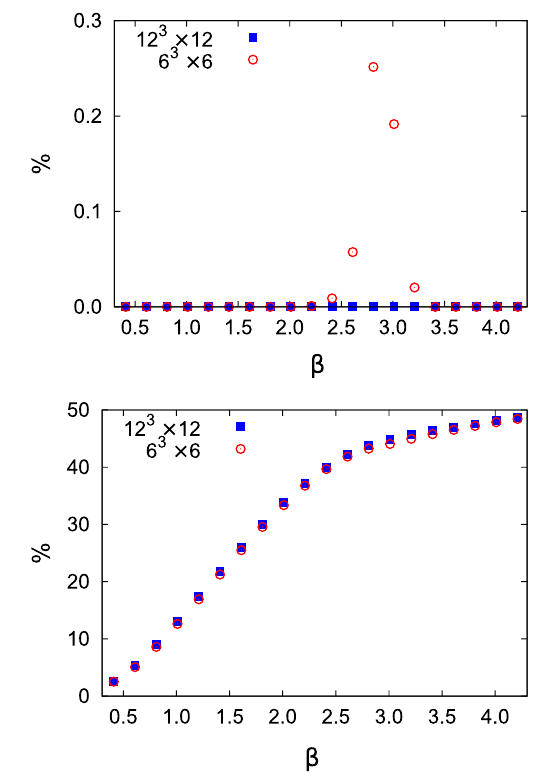
Fig. 8 Efficiency of the algorithm for the various updates. Top panel: nonlocal update, see Sect. 4.2. Bottom panel: local updates using the function F 40 , see Sect.